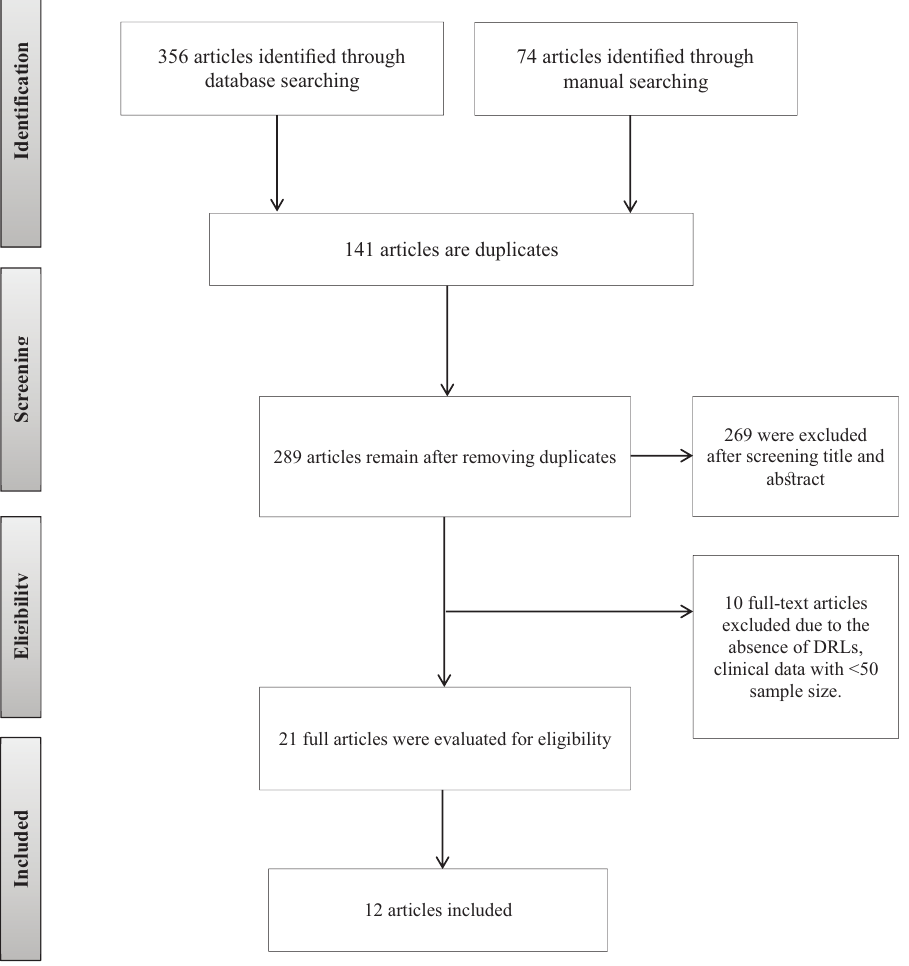
Figure 1 : Flow chart of Preferred Reporting Items for Systematic Review and Meta-Analysis